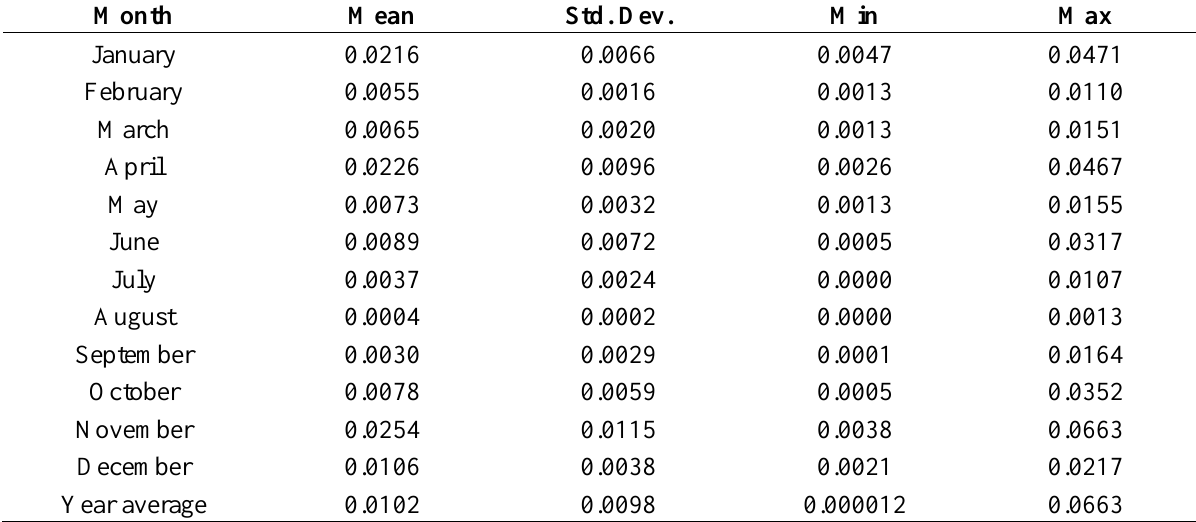
Table 3. Monthly estimated probability of Highly Pathogenic Avian Influenza (HPAI) H5N1 in the Red River